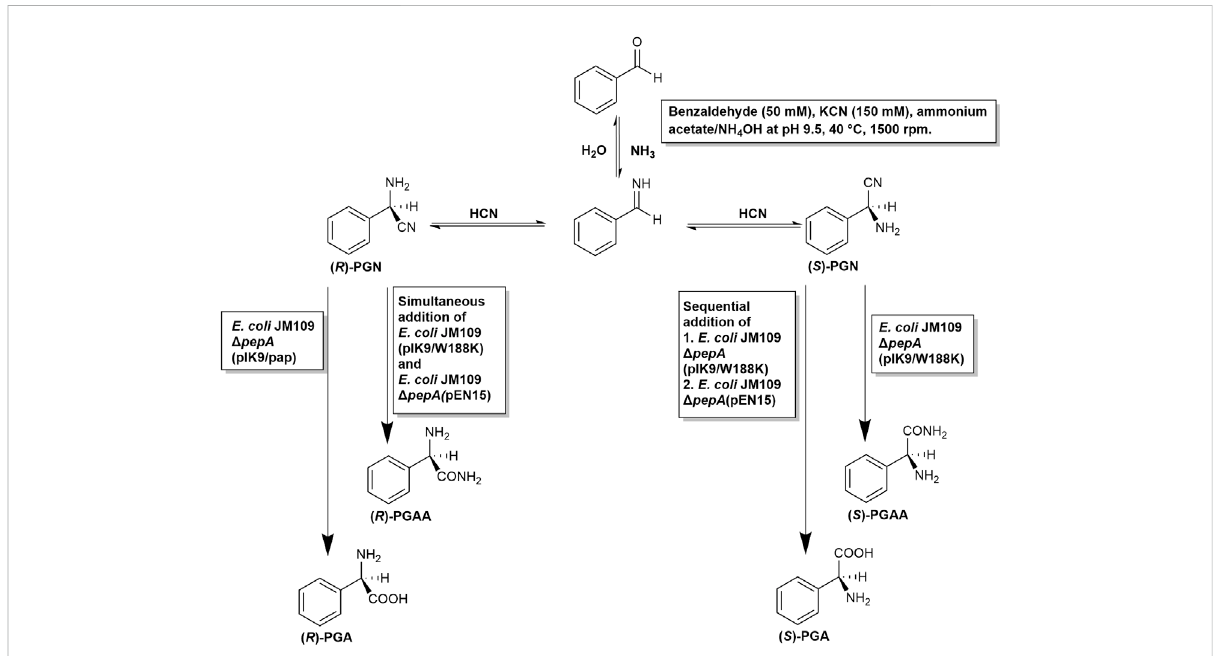
FIGURE 9 Developed chemoenzymatic synthesis of enantiomerically enriched ( R )- and ( S )-phenylglycine and ( R )-and ( S )-phenylglycine amide from benzaldehyde, cyanide, and